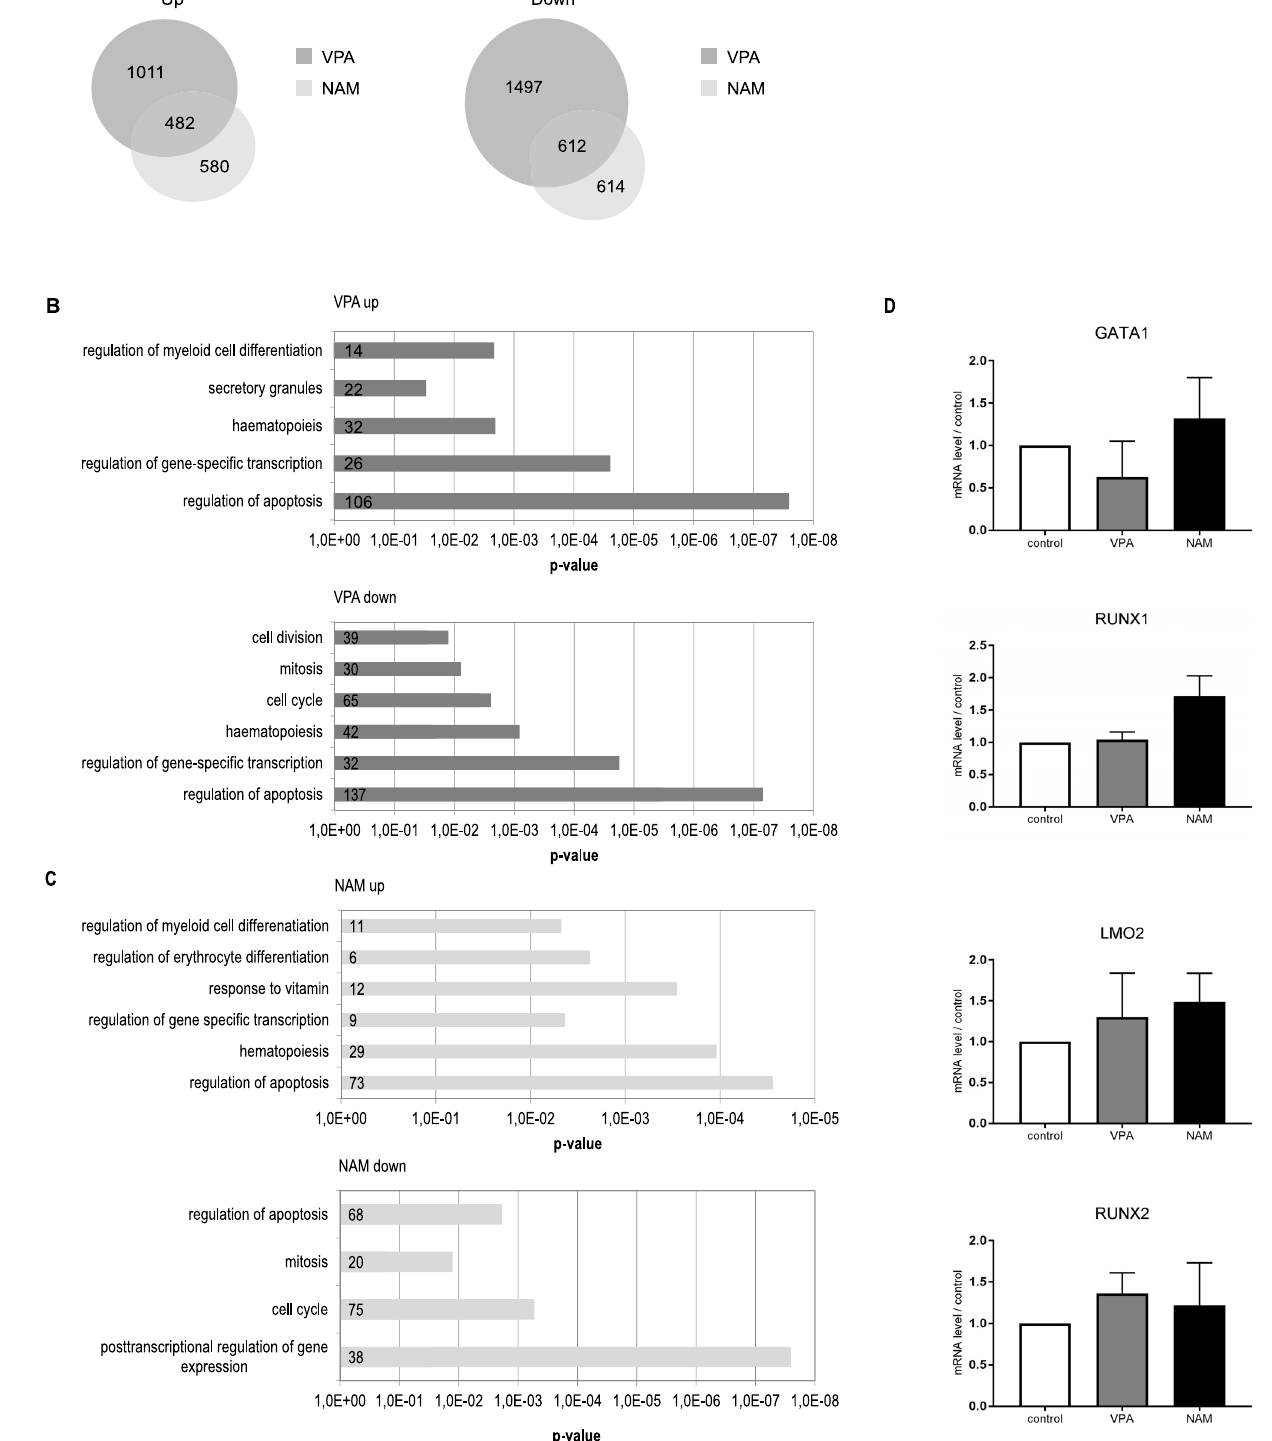
Fig 5. VPA and NAM treatment modulates H3K27 acetylation at the promoters of myeloid specific genes. UCB-derived CD34+ cells were differentiated towards megakaryocytes. At day 4 of differentiation, cells were treated overnight with 200μM, or 5mM NAM. Next, lysates were prepared, followed by ChIP-sequencing (see Methods). Data represent a Venn diagram comparing the number of genes identified based on a > 2-fold increase or decrease in H3K27 acetylation levels compared to the control (A). Gene ontology analysis of up- and down-regulated genes by VPA (B) and NAM (C)